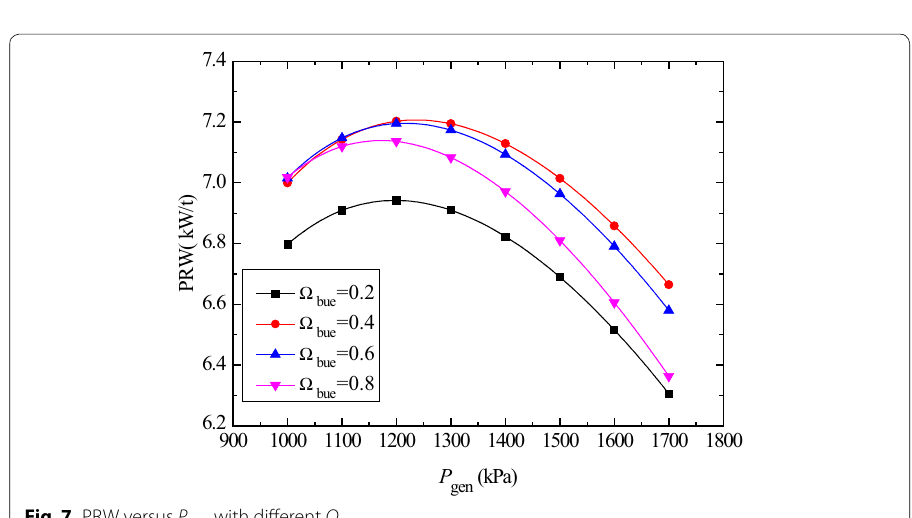
Fig. 6 η th versus P gen with different Ω bue